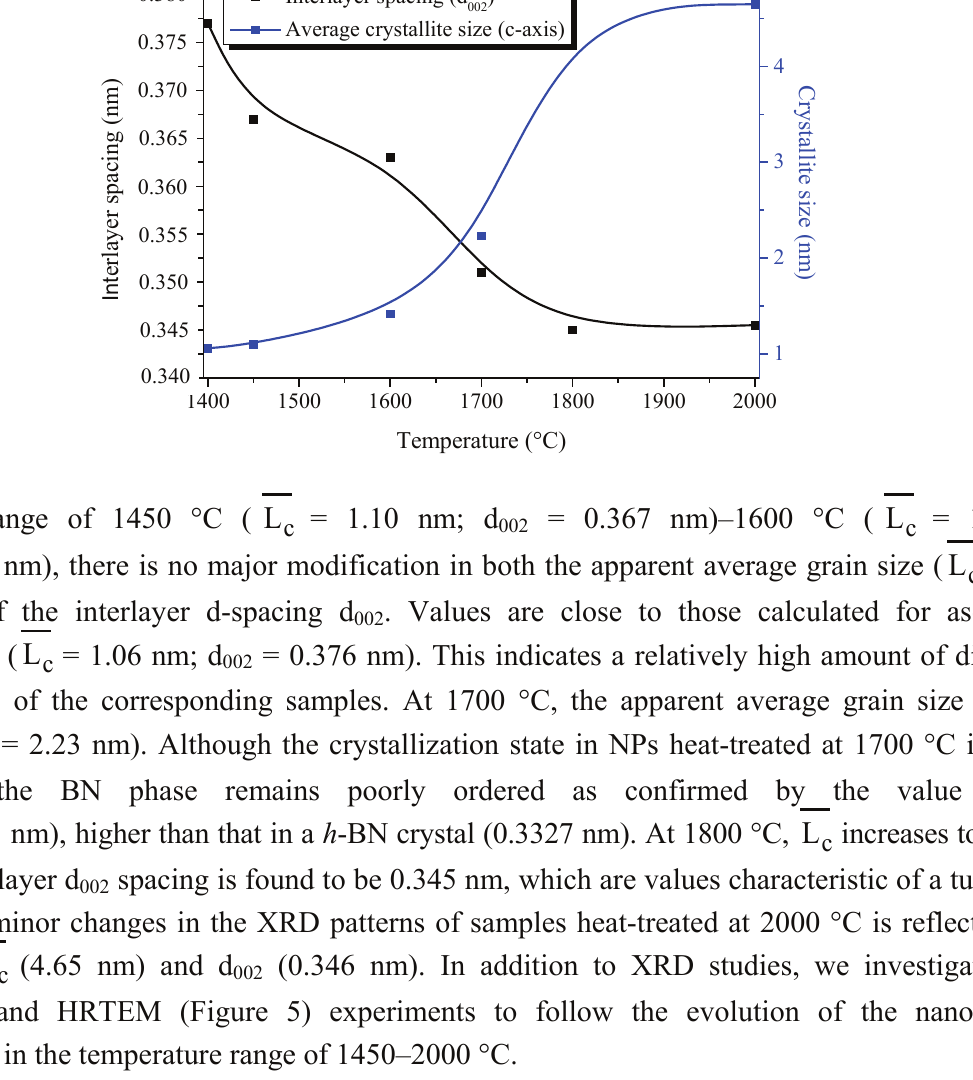
Figure 3. Evolution of L